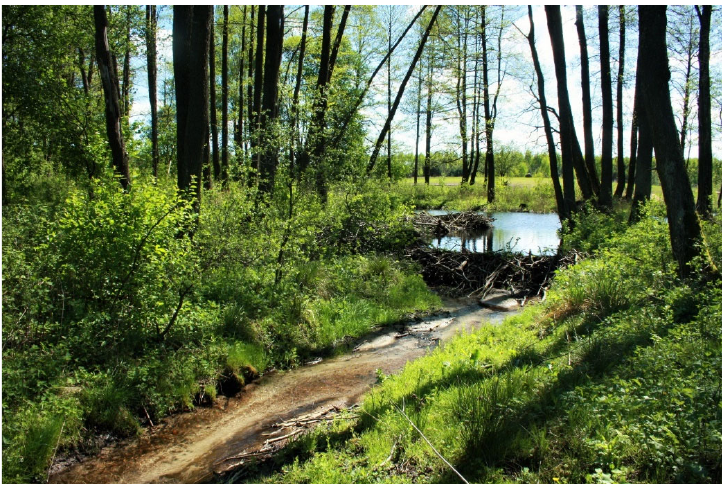
Figure 6. Artificial limnocrene created as a result of the construction of a beaver dam (spring No. 57).